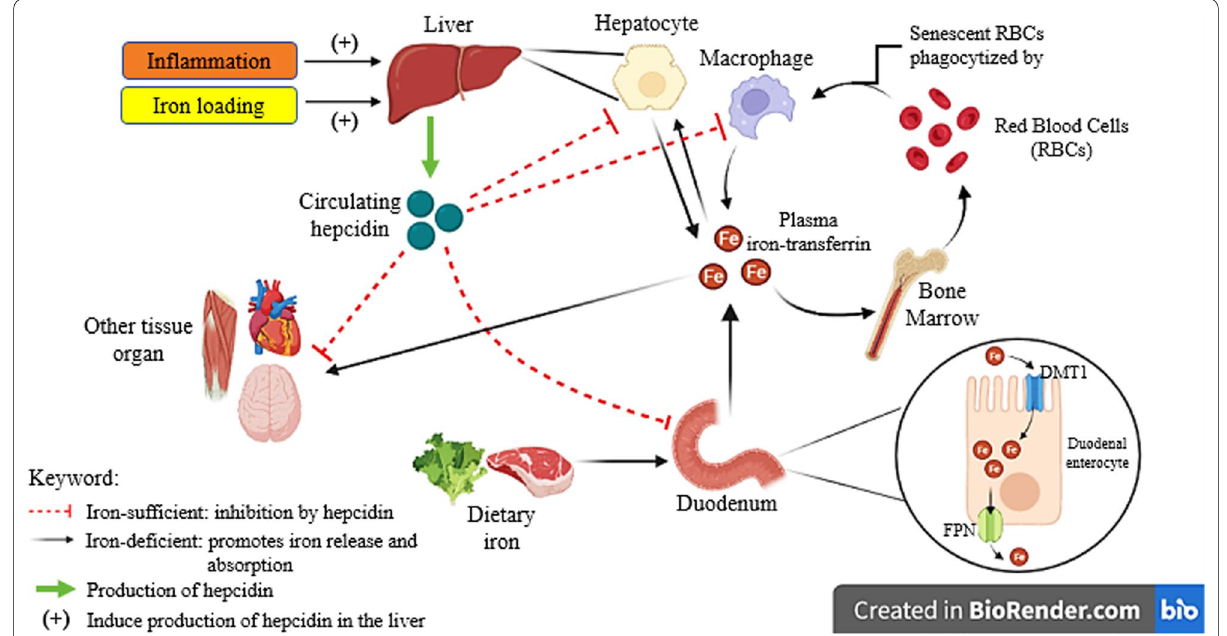
Fig. 2 Regulation of iron homeostasis. Dietary iron absorbed through the enterocytes (shown in the circle), mainly in the duodenum. The absorbed dietary iron is then exported into the circulation passing through the basolateral membrane via FPN. Iron is then transported throughout the body tissues by binding to the circulating transferrin in the blood circulation. Most of the iron is utilised in the bone marrow to produce haemoglobin and RBCs. When senescent, the RBC will be phagocytised by macrophages and the iron will be released into the plasma following the body need. The liver-derived peptide hepcidin regulates body iron intake and distribution by binding to plasma membrane FPN on enterocytes, macrophages, and other body cells and stimulating its internalisation and destruction. In an iron-deficient body, hepcidin concentrations are low, stimulating iron absorption and delivery to the plasma, and into other tissue organs; in an iron-sufficient body, hepcidin concentrations are higher, inhibiting iron release from reserves, restricting iron absorption into the plasma and iron uptake into the tissue organs. This figure was created using BioRender.